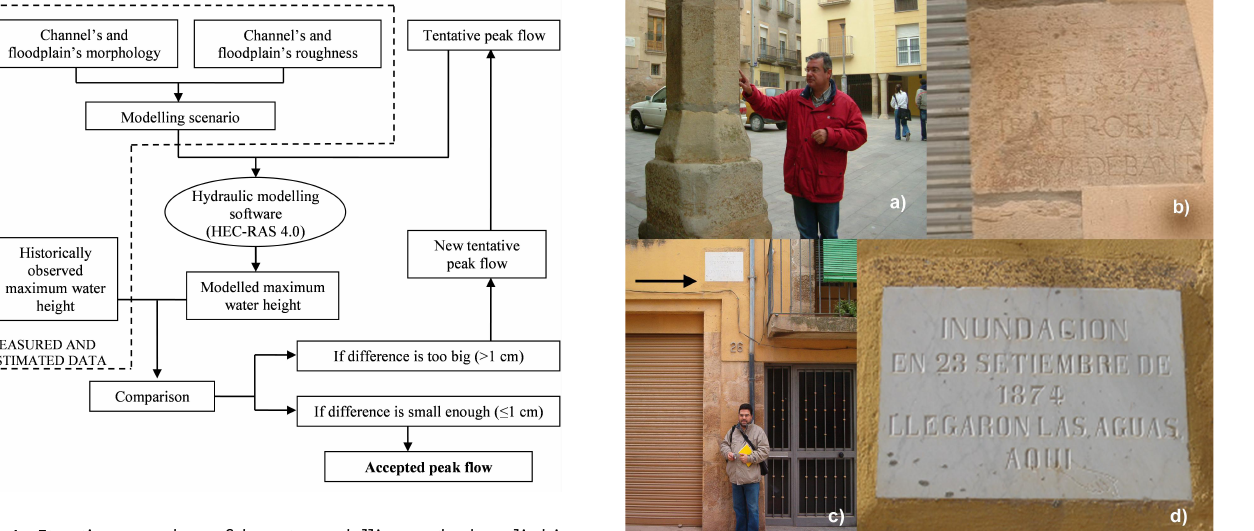
Fig. 4. Iterative procedure of the retromodelling method applied in each reconstructed flood.